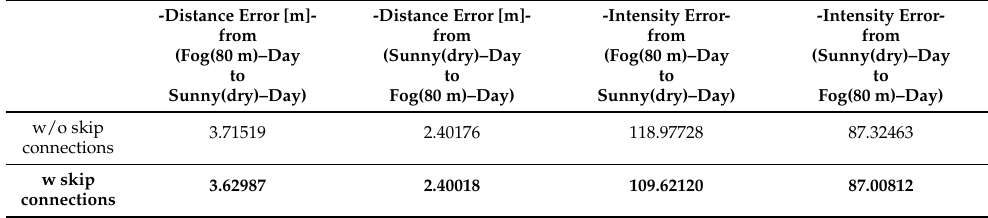
Table 5. Error results with and without skip-connections. The numbers in the table indicate the dis- tance and intensity errors. The bold numbers prove that the proposed method with skip-connections outperforms that